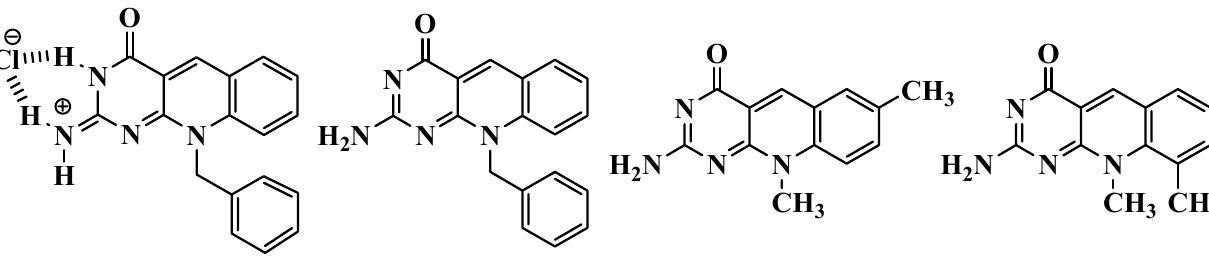
Figure 2. Pyrimido[4,5- b ]quinoline derivatives